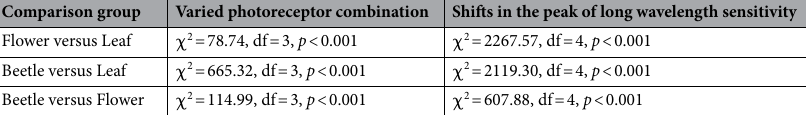
Table 1. Wald Chi-square test results among contrasts of visual systems in different comparison groups.